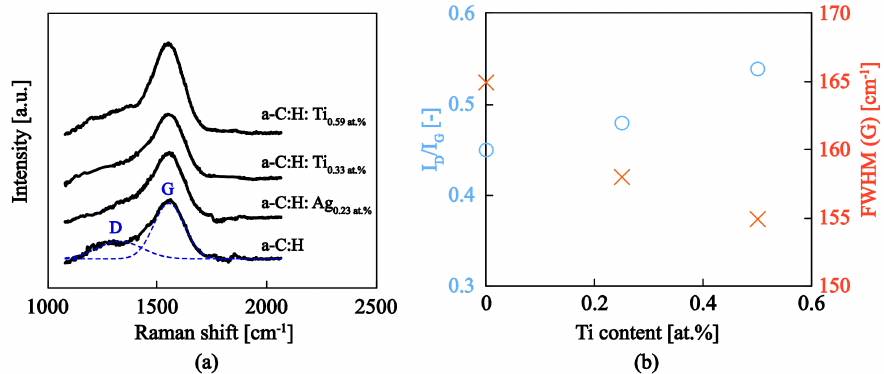
Figure 7. ( a ) Raman spectra for the a–C:H:Me nanocomposite films tested within this study showing also the deconvoluted Raman spectra for a–C:H, fitted by Gaussian curves at D and G carbon band resonant frequencies. ( b ) Extracted I D / I G and FWHM(G) as a function of titanium content for the a–C:H:Ti films synthesized